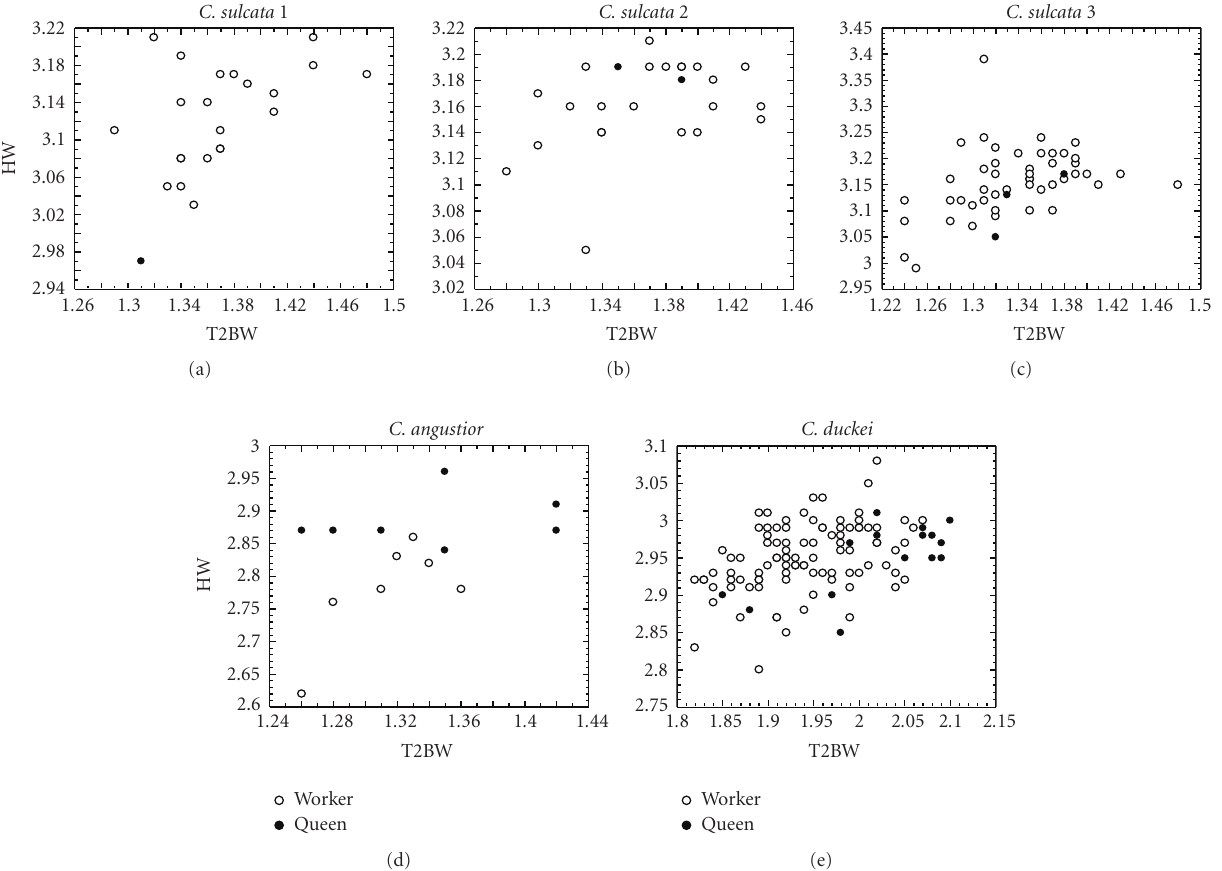
Figure 4: Caste discrimination in the analyzed colonies of Clypearia based on the multivariate analyses.